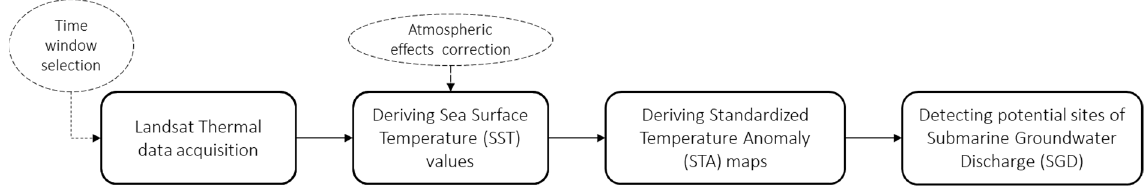
Figure 1. Methodological flow chart for the selection, acquisition, processing and analysis of the Thermal Infrared Landsat 8 images.